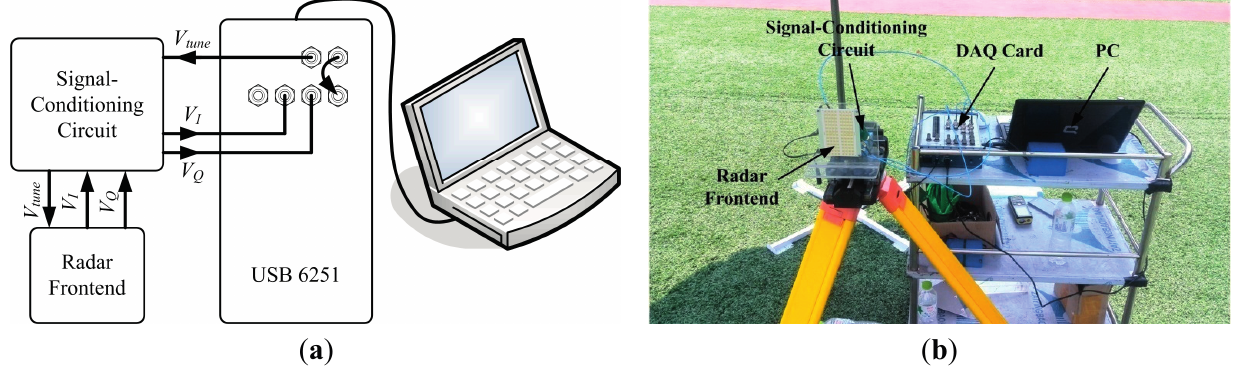
Figure 9. Fabricated FMCW radar sensor. ( a ) Specific connection between actual components; ( b ) Photograph of the